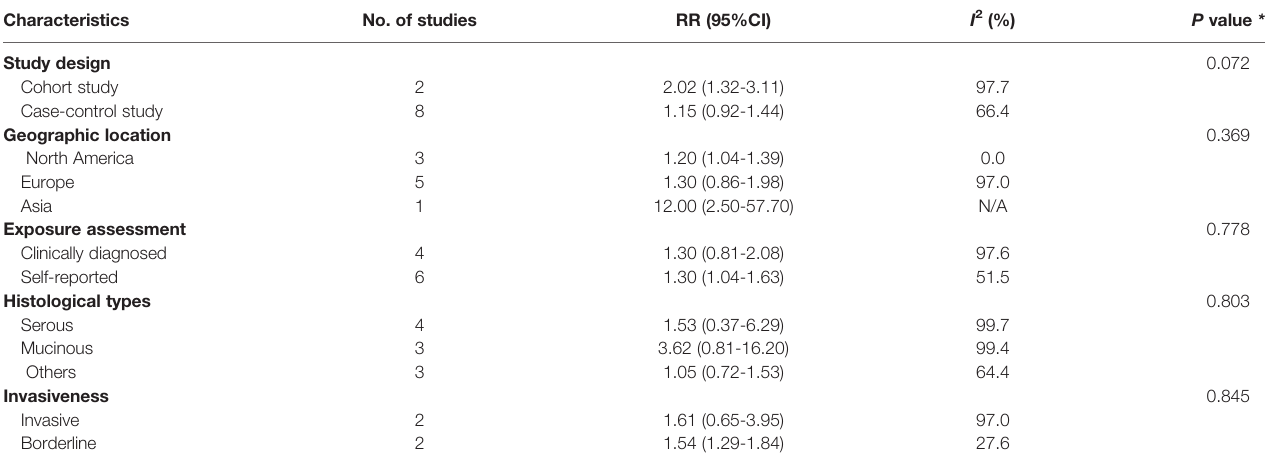
TABLE 2 | Associations of ovarian cysts with ovarian cancer risk strati fi ed by subgroups. Characteristics No. of studies RR (95%CI) I 2 (%) P value